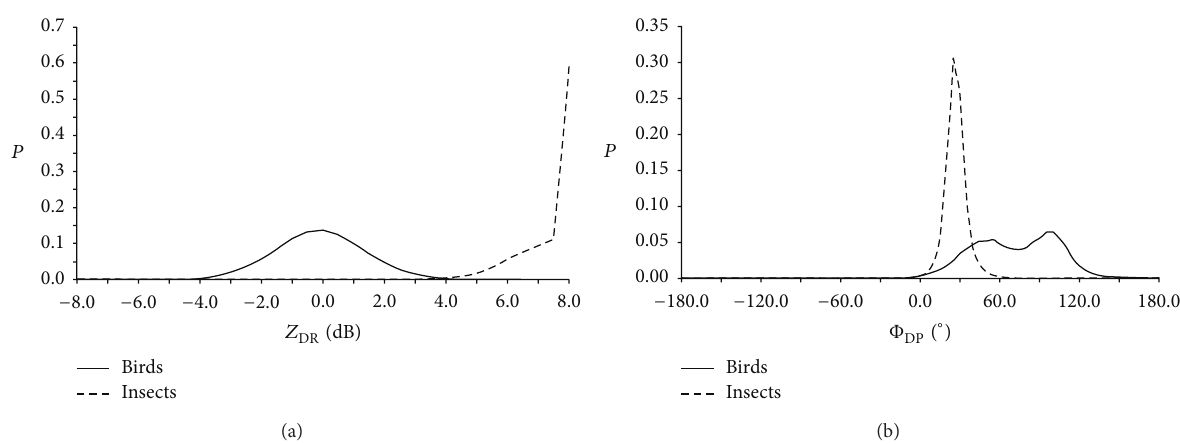
Figure 4: Normalized histograms of (a) 𝑍 and by the dashed curve for